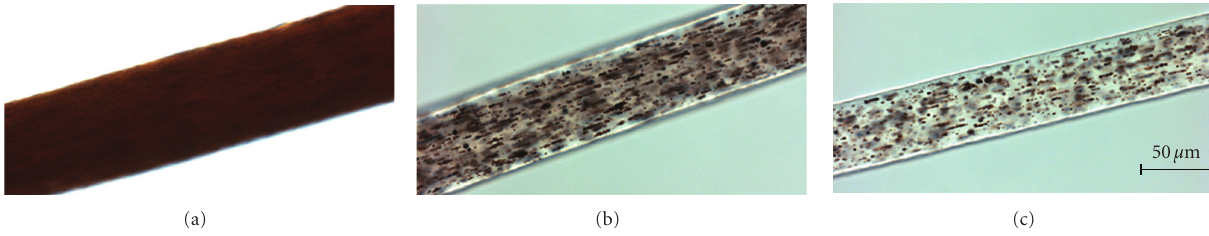
Figure 4: Hair shaft samples under high powered light microscopy. (a) African-American control hair sample, demonstrating evenly distributed pigment in the hairshaft. (b) Hair sample of a previously published severely a ff ected Chediak-Higashi syndrome patient [19], demonstrating an atypical granular distribution of “pigmented clumps” in the hair shaft. (c) Hair sample of our African-American patient with Chediak-Higashi syndrome, demonstrating a similar atypical granular pigmentation pattern as the CHS patient in (b). All images were taken at the same settings using a 40X/1.3 oil objective on an Axiovert200M light microscope.